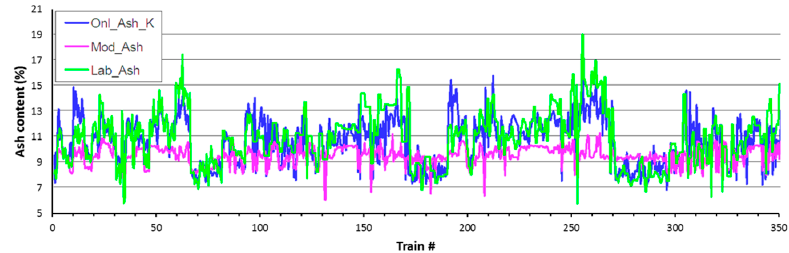
Figure 8. The sub-process of the continuous mining system.